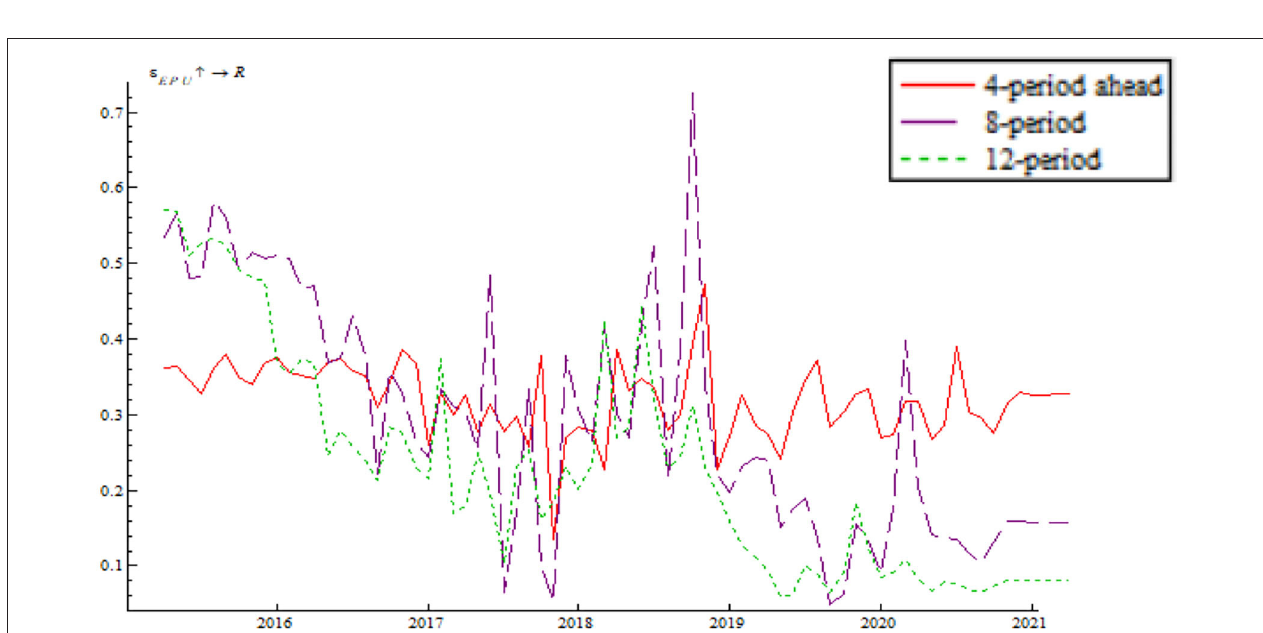
FIGURE 6 | EPU’s shock on quantitative monetary policy.